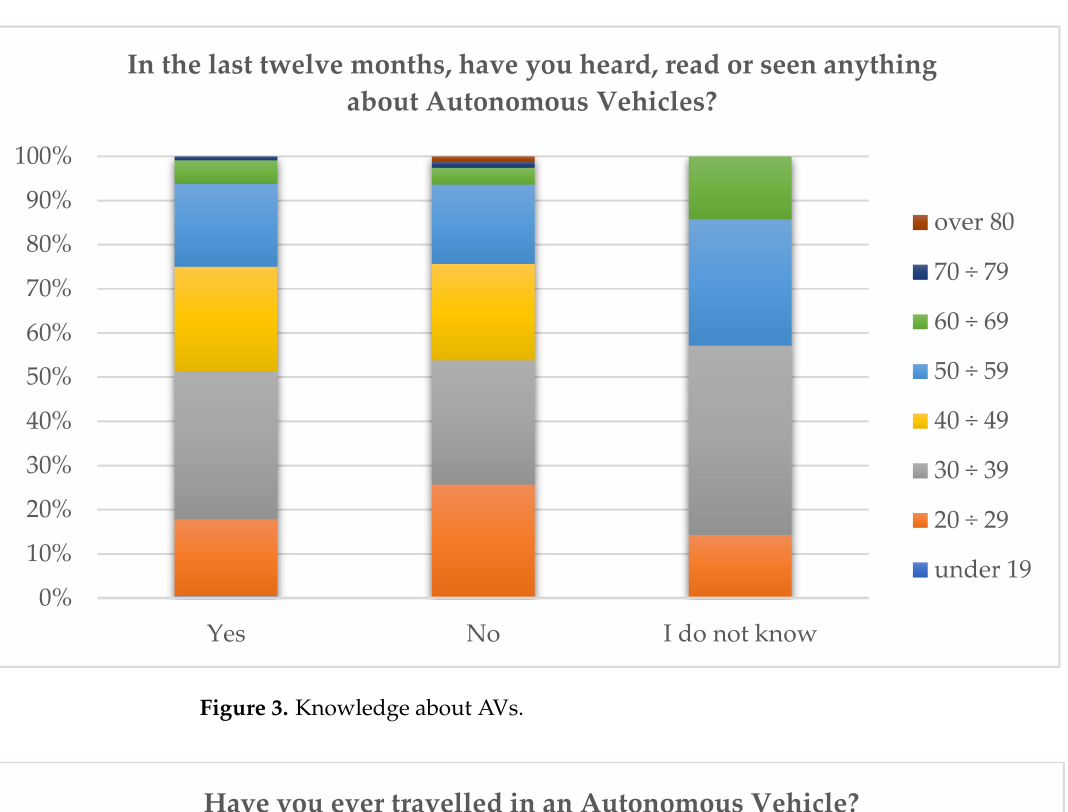
Figure 3. Knowledge about AVs.